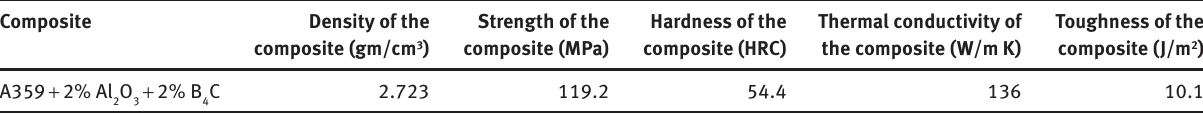
Table 5: Basic physical and mechanical properties of the tested hybrid MMC. Composite